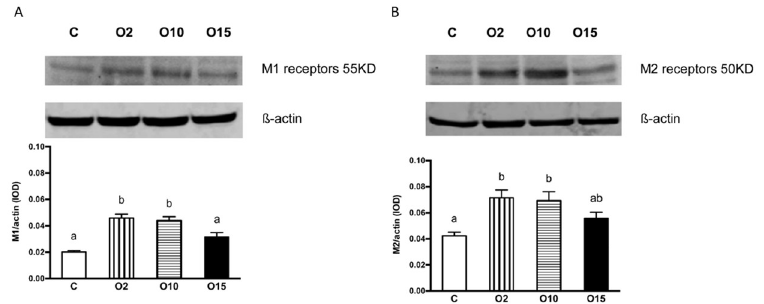
Fig 4. Western blot analysis of M1 receptor expression [IOD] in the mucosa of middle jejunum segments in newborn pigs and optical density of the M1 receptor b-actin ratio in the study groups (A). Western blot analysis of M2 receptor expression [IOD] in the mucosa of middle jejunum segments in newborn pigs and optical density of the M2 receptor b-actin ratio in the study groups (B). Piglets fed milk formula with intra-stomach administrations of obestatin (2 μ g/kg body weight (BW)–O2, 10 μ g/kg BW–O10, 15 μ g/kg BW–O15) or 0.9% NaCl–C, every 8 hours. Results are presented as means ± SEM. a,b,c - indicates statistical differences between groups.